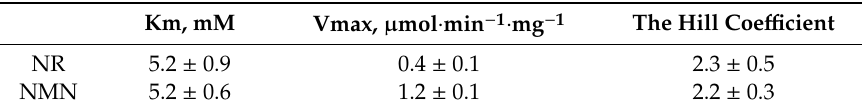
Figure 2. Apparent K m and V max determination of NadR from L. lactis for the substrate nicotinamide riboside at the constant ATP concentration of 10 mM ( A ) and for ATP at the constant NR concentration of 1 mM ( B ). Table 3. Apparent K m , V max and the Hill coe ffi cient values of NadR from L. lactis for ATP in the presence of a constant concentration of NR or NMN (1mM